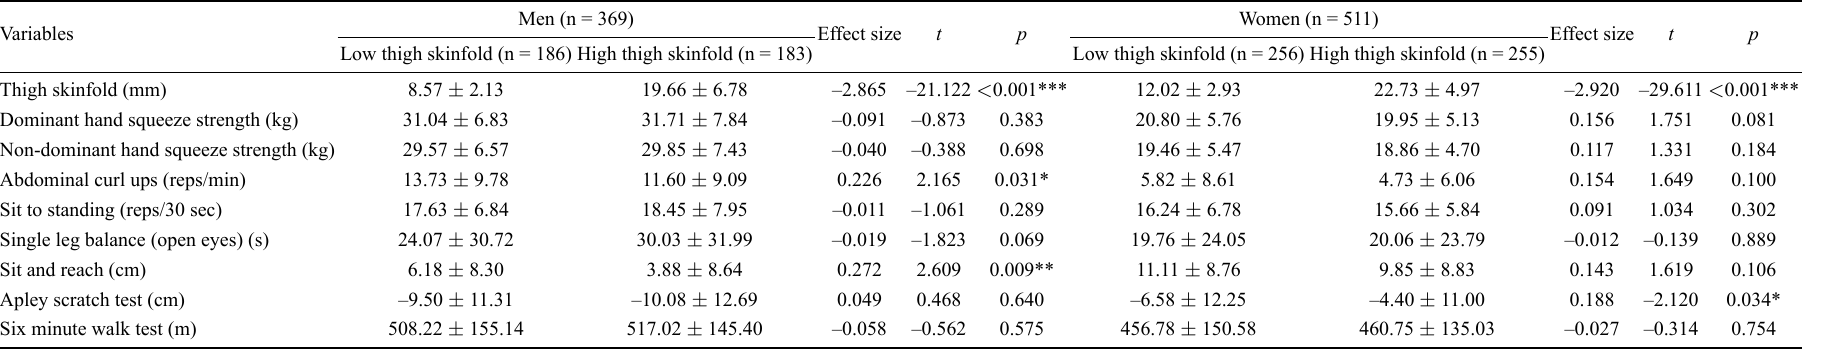
Table 3. Results of independent t -test for sex differences in the older (aged over 65 years).